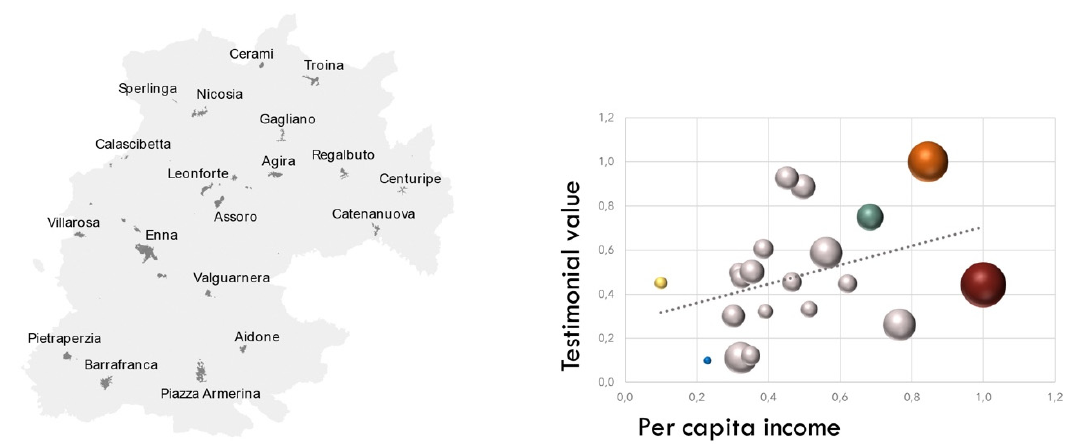
Figure 11. Maps and correlations of Per capita income and Urban area testimonial value in the 20 municipalities (numerical values under the colour ramp).